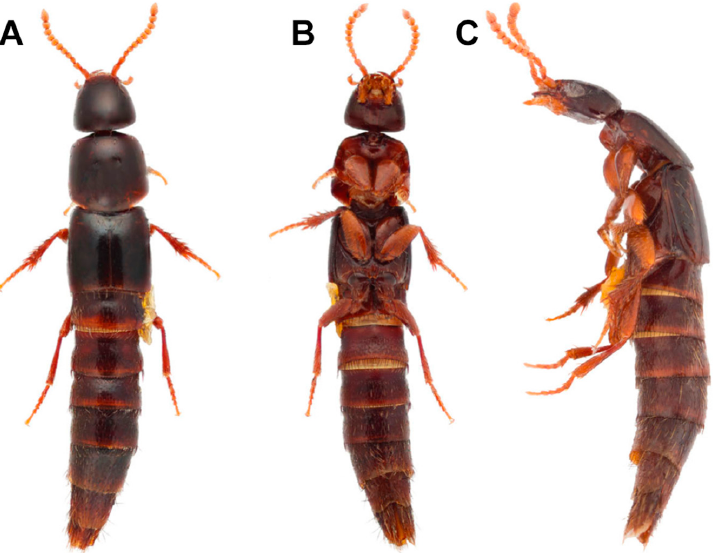
Figure 1. Coomania sp. Habitus: ( A ), dorsal view. ( B ), ventral view. ( C ), lateral view. Reproduced from Ż y ł a and Solodovnikov [12].